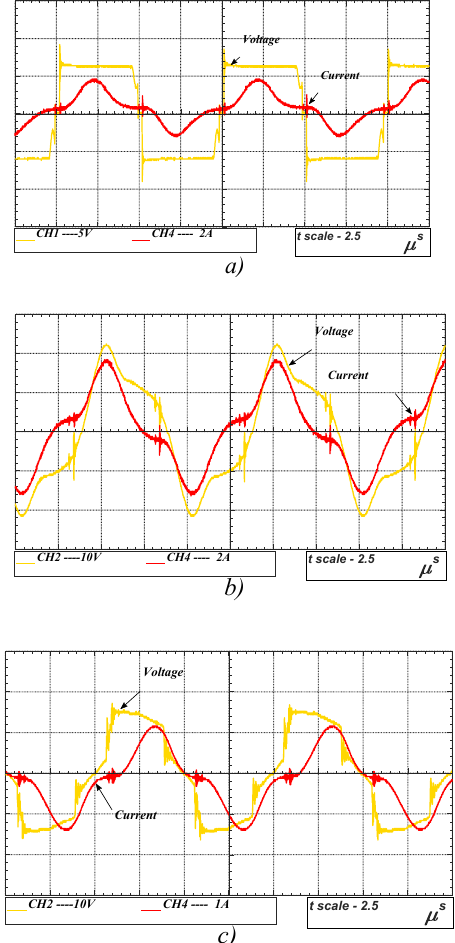
Fig. 5. Waveforms at a distance of 1 mm between coils: a) output voltage of the inverter ( V inv ) and the current on the primary side ( I prim ); b, c) voltage ( V sec ) and the current on the secondary side ( I sec ) (after the secondary capacitor before the diode bridge). Waveforms at a distance of 1 mm coils are shown in Fig. 5.